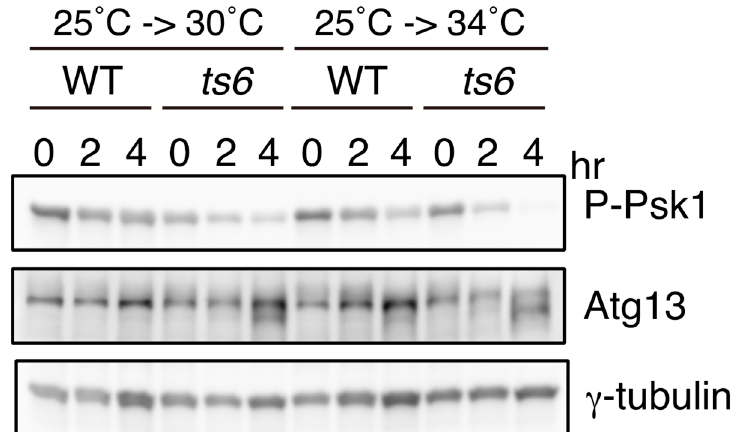
Figure 2. Phosphorylation of Atg13 and Psk1 is regulated by TORC1 in vivo. Phosphorylation of Atg13 and Psk1 in a temperature ‐ sensitive tor2 mutant. Wild ‐ type (WT; JY3: h 90 ) and tor2 ‐ ts6 (JT360: h 90 tor2 ‐ ts6 ) cells were grown in YE (Yeast Extract) medium at 25 °C (4 × 10 6 cells/mL), and then shifted to 30 °C or 34 °C after dilution with the same amount of fresh YE. Cells were disrupted with glass beads in 20% trichloroacetic acid. Cell extracts were subjected to Western blot analysis by using anti ‐ Atg13 antibody (×1000) [24] and anti ‐ phospho ‐ S6 kinase (Thr389) antibody (×1000) (1A5, Cell Signaling Technology, Danvers, MA, USA). Anti ‐γ‐ tubulin antibody (GTU ‐ 88, Sigma ‐ Aldrich, St. Louis, MO, USA) (×2000) was used as a loading